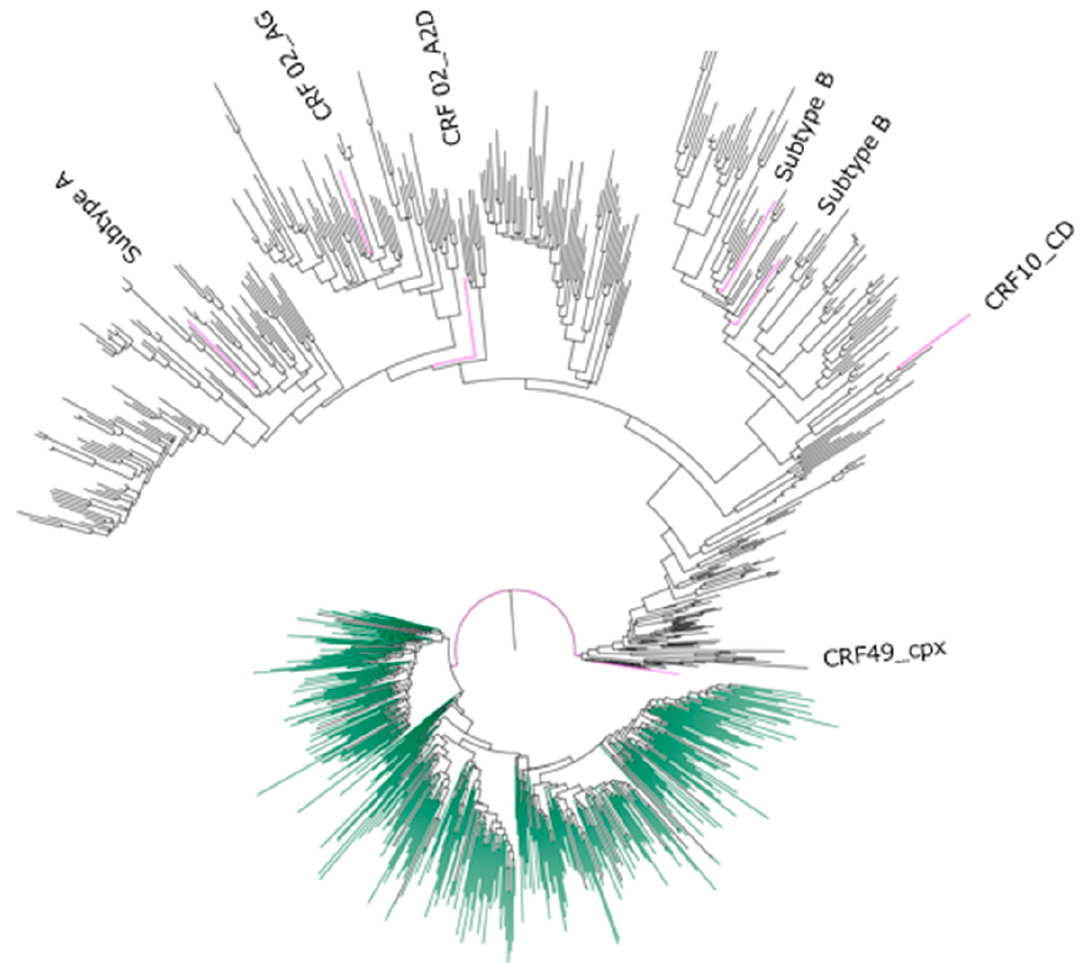
Figure 1. Maximum-likelihood phylogenetic tree of HIV-1 viral strains circulating in Ethiopia using integrase (IN) sequences.